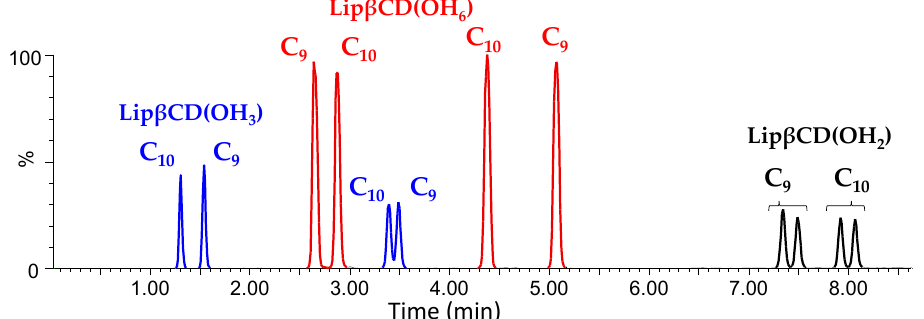
Figure 8. Final assignment of the 12 chromatographic peaks obtained by UHPLC-HRMS, described by the grafted position on β CD (OH 2 , OH 3 and OH 6 ) and on methyl oleate (C 9 , C 10 ).